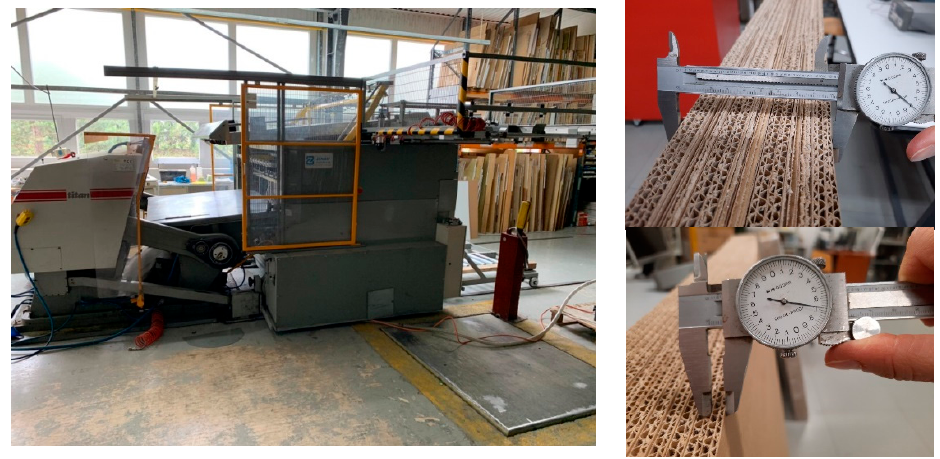
Figure 2. ( Left ), die-cutting machine for the industrial production of panels. ( Right ), two prototypes used for the tests.